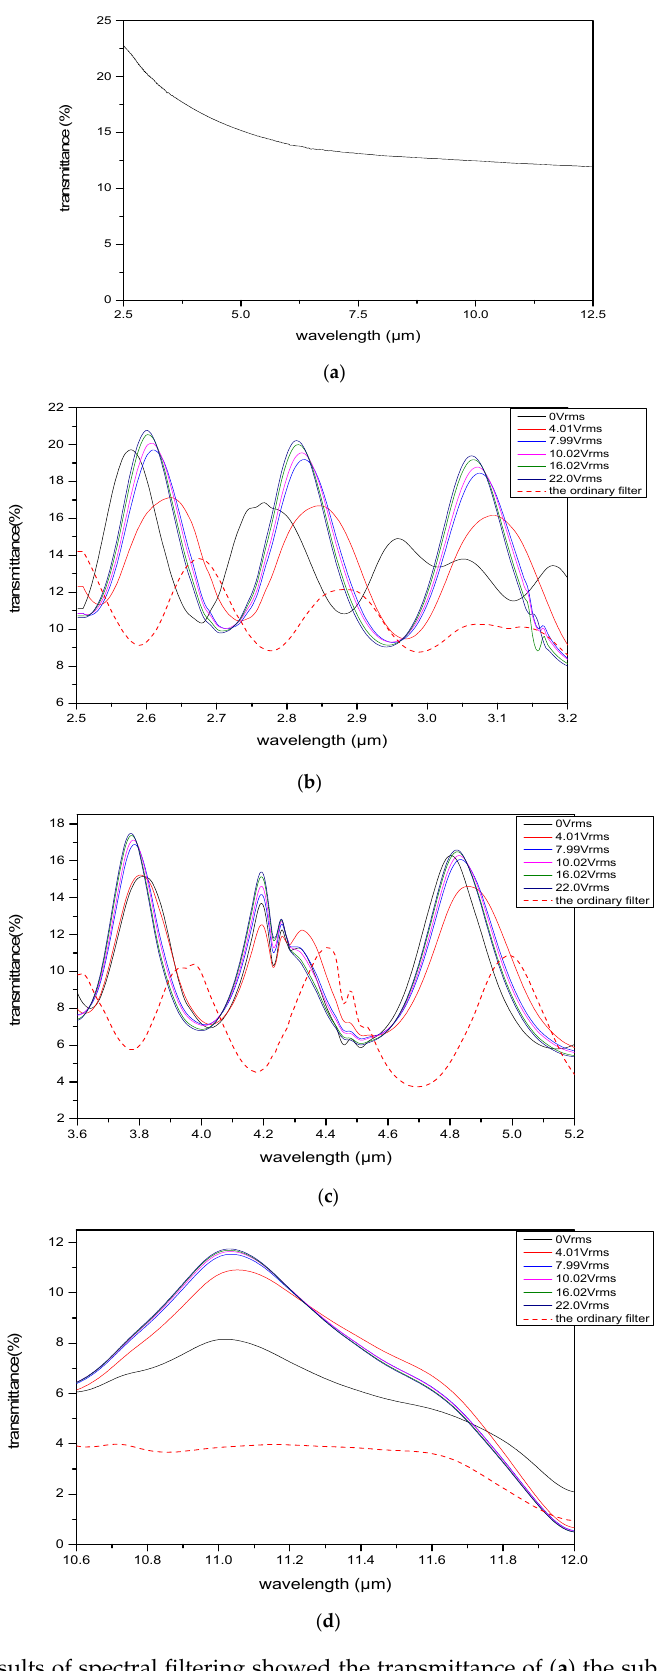
Figure 2. The results of spectral filtering showed the transmittance of ( a ) the substrate covered by Al film; ( b ) wavelength band from 2.5 to 3.2 µ m; ( c ) wavelength band from 3.6 to 5.2 µ m; and ( d ) wavelength band from 10.6 to 12.0 µ m. The signal voltages included were 0 V rms , 4.01 V rms , 7.99 V rms , 10.02 V rms , 16.02 V rms , and 22.00 V rms .